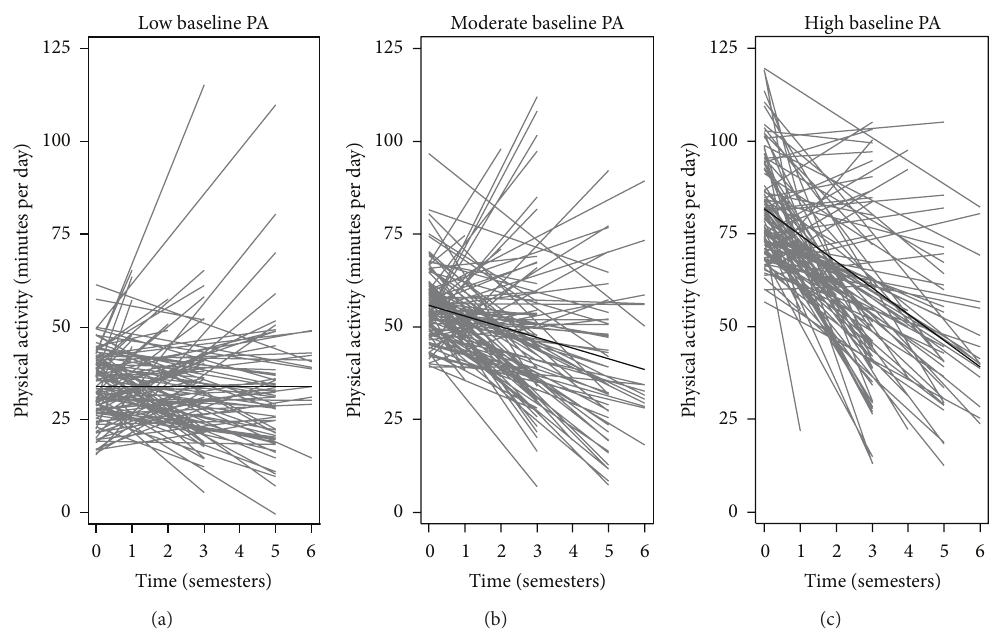
Figure 2: Physical activity trajectories of students from April 2008 to December 2011, by baseline physical activity. Linear regressions of physical activity (minutes per day) across semesters for each student with baseline and at least 1 valid follow-up measurement, by baseline PA, are shown in gray. Linear growth curves showing averaged baseline physical activity and averaged rate of change in physical activity among all students, by baseline PA, are shown in